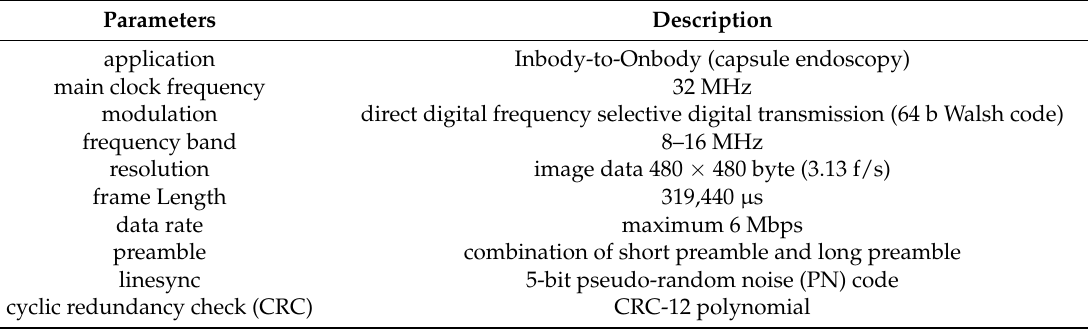
Table 1. Parameters of capsule endoscopy with a human body communication (CEHBC) system.